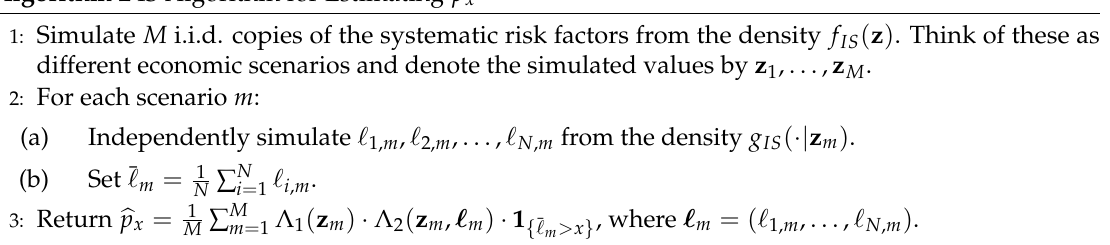
Algorithm 2 IS Algorithm for Estimating p